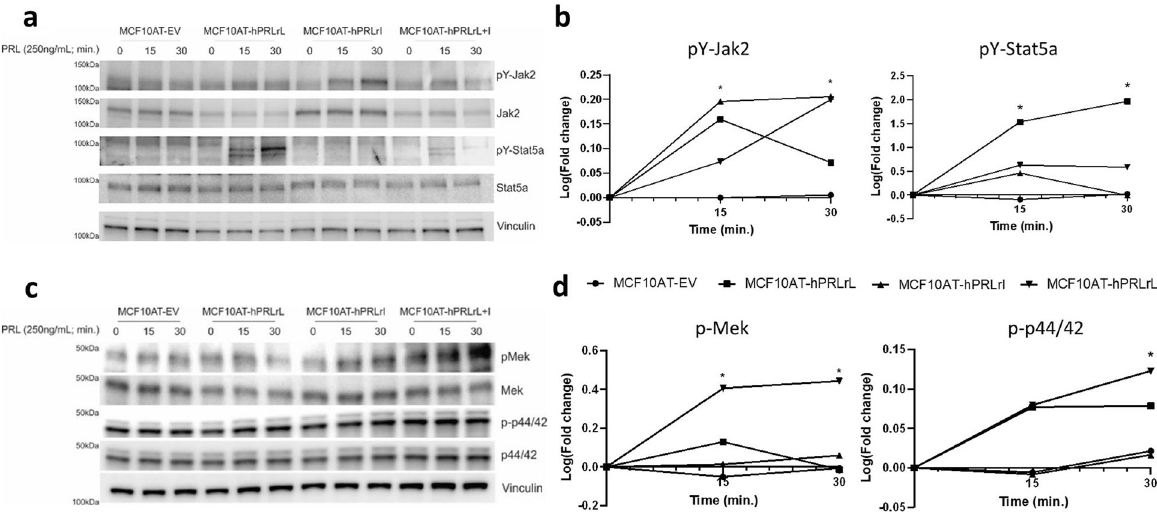
Fig. 5 hPRLrL + I heterodimer signal transduction. MCF10AT transfectants were PRL (250 ng/mL) stimulated for 0, 15, and 30 min, and phospho-IB was utilized to assess the activation status of a , b Jak2/Stat5a and c , d Mek/Erk. Band intensities were quanti fi ed using densitometry. Signi fi cance was determined by comparing each condition to the MCF10AT-EV negative control for each respective time point. * p < 0.05, n =